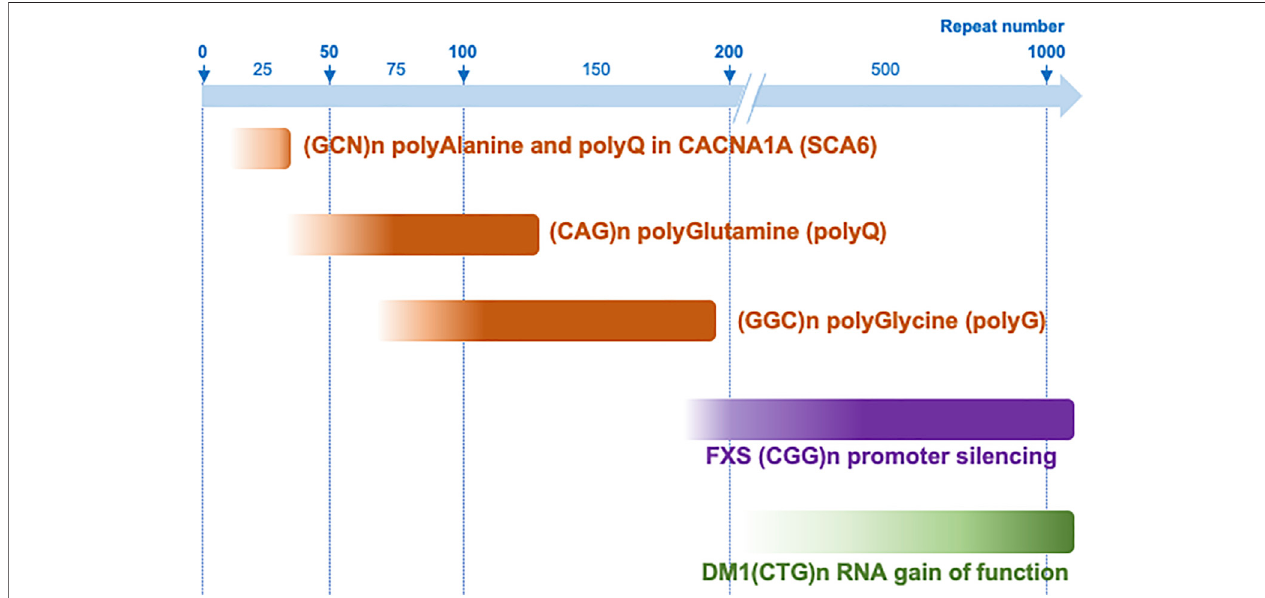
FIGURE4| Repeatexpansionrangeoftoxicityindifferentmicrosatellite diseases. CGGrepeat expansions arepathogenicbetween~60 – 70and200 – 300repeats when they areexpressed into toxic polyglycine-containing proteins, but over 200repeats when they promote DNA epigenetic changes, promoter silencing and aloss of function mechanism, such as in FXS. This range of protein toxicity is to be compared to other translated microsatellite diseases such as polyalanine-containing proteins that are generally toxic with 10 – 35 GCN repeats, while polyQ proteins are generally pathogenic with longer CAG expansions (~40 – 80 – 200 repeats), with the exception of short polyglutamine stretch altering functions of the calcium voltage-gated channel subunit alpha1A (CACNA1A) in SCA6. In contrast, an RNA gain of function mechanism such as titration of the MBNL RNA binding proteins in DM1, require much longer repeat expansions.